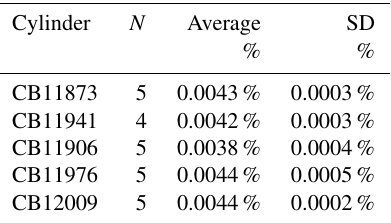
Figure 2. Typical result from Schibig et al. (2018) CO 2 decanting with decreasing cylinder experiments showing an increase in X CO 2 pressure. The fraction of CO 2 adsorbed was found by comparing the area under the Langmuir isotherm (blue line) with the area un- der the Langmuir isotherm but above the initial CO 2 mole fraction (dashed line). The adsorbed CO 2 calculated this way, expressed as a mole fraction, is similar to the parameter CO 2 , ad from the Lang- muir model (Leuenberger et al., 2015; Schibig et al., 2018). Fit pa- rameters, K , CO 2 _ad, and CO 2 _init, are described in Leuenberger et al. (2015). Table 3. Summary of CO 2 adsorption experiments. For each cylin- der, the test was repeated N times. Adsorbed CO 2 is expressed as a fraction of the total CO 2 in the